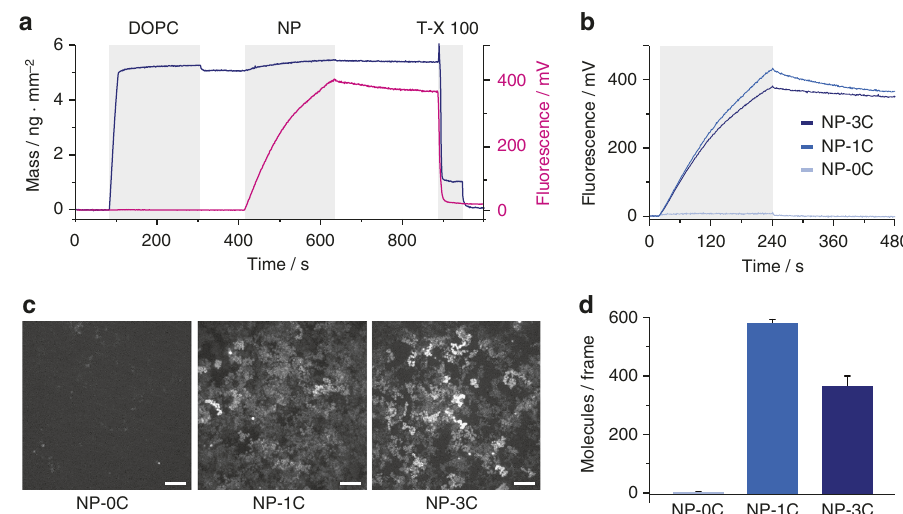
Fig. 2 Cholesterol-dependent NP binding to PSMs. a , b Kinetics of DNA NP binding to polymer-supported membranes (PSM) as monitored by simultaneous total internal re fl ection fl uorescence and re fl ectance interference spectroscopy (TIRFS-RIf) detection. a Spontaneous PSM formation upon binding of 1,2-dioleoyl-sn-glycero-3-phosphocholine (DOPC) vesicles was con fi rmed by label-free RIf detection (dark blue line). The kinetics of 100 n M AF647 NP-3C binding to the PSM could be resolved with high signal-to-noise by TIRFS (magenta line), while the surface coverage could be estimated from the RIf signal. Subsequently, the surface was regenerated by a detergent wash to allow repeated experiments under the same conditions. b Comparison of the TIRFS signal obtained for 100 n M AF647 NP-0C, AF647 NP-1C, and AF647 NP-3C. c , d DNA NP binding quanti fi ed by TIRFM. c Representative maximum intensity projection of 100 frames acquired after incubating PSMs with 5 p M NP-0C, NP-1C, and NP-3C, respectively. Scale bars: 5 µ m. d Quanti fi cation of detected single-molecules in a full frame (512×512 pixel) after incubation of the PSM with 5 p M of NPs for 10 min (mean and s.d. of n = 3 pore NP-3C (Fig. 1a, b) 23 . NP variants with a single cholesterol moiety (NP-1C) or no lipid anchor (NP-0C) were used as con- trols (Fig. 1c). For detection and reliable quanti fi cation, a single Alexa Fluor 647 fl uorophore (Fig. 1b) was attached to one of the unmodi fi ed strands of the NPs yielding AF647 NP-3C, AF647 NP- 1C, and AF647 NP-0C (Supplementary Fig. 1 and Supplementary